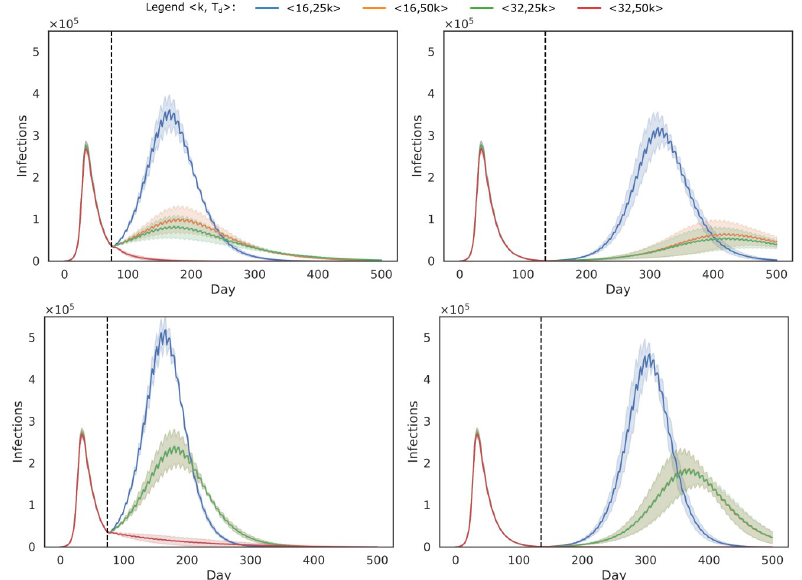
Fig 2. Trends (average and standard deviations) for all combinations of parameters h k , T d i , for FNR PCR = 0.1. Universal testing starts at the first of May (left panels) and the first of July (right panels), as indicated by the vertical dotted line, which also marks the end of the lock-down. In the top panels, we follow the pool isolation strategy, where we isolate all individuals that are part of an infected pool. In the bottom panels, we follow the individual isolation strategy, where we identify the infected individuals in positive pool.